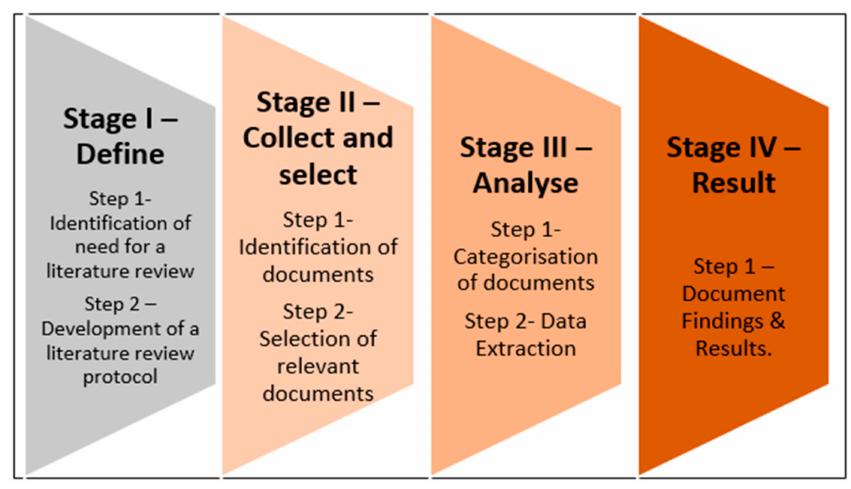
Figure 3. Systematic literature review phases . As adapted from Tranfield et al.